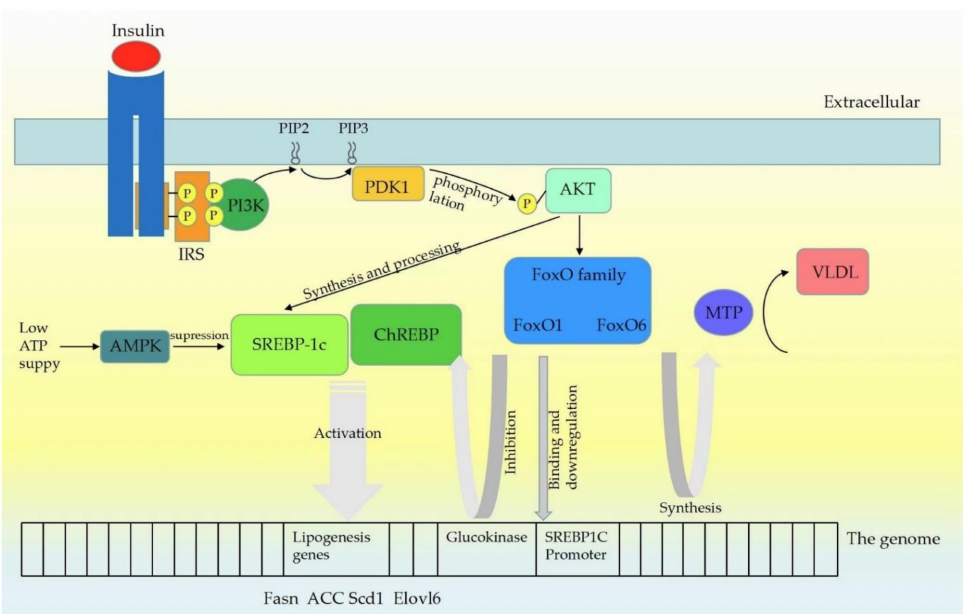
Figure 1. Insulin signaling pathway mechanism. Upon insulin receptors binding to ligands, leading to self-phosphorylation, insulin receptor substrates (IRS) are recruited and phosphorylated. IRS proteins are then recruited and activate PI3K, which phosphorylates PIP2 to generate PIP3. PDK1